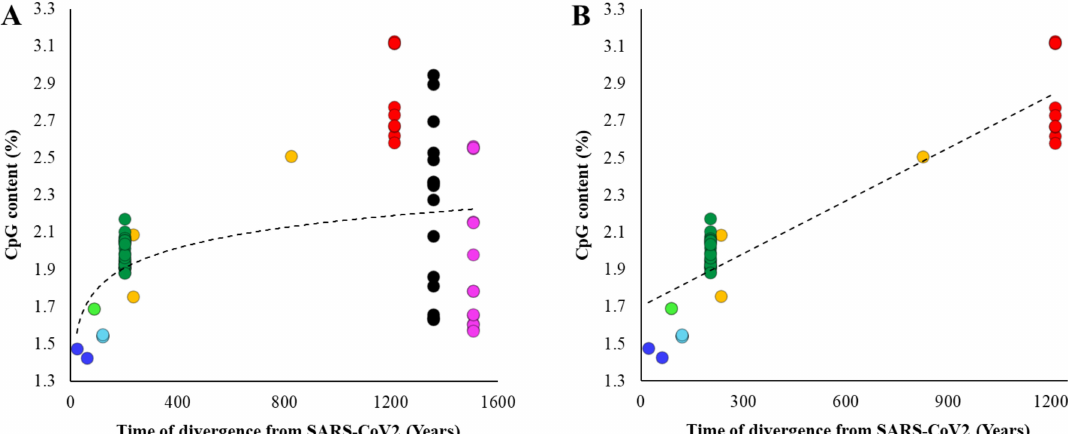
Figure 2. Relationship between divergence times of other betacoronaviruses from SARS-CoV-2 and their CpG contents. The divergence times for each node shown in Figure 1. ( A ) All genomes were included. The correlation is not significant ( ρ = 0.18, p = 0.12). ( B ) Embecovirus and Merbecovirus genomes were excluded. The correlation is highly significant ( ρ = 0.86, p < 0.00001). Best fitting regression lines are shown.